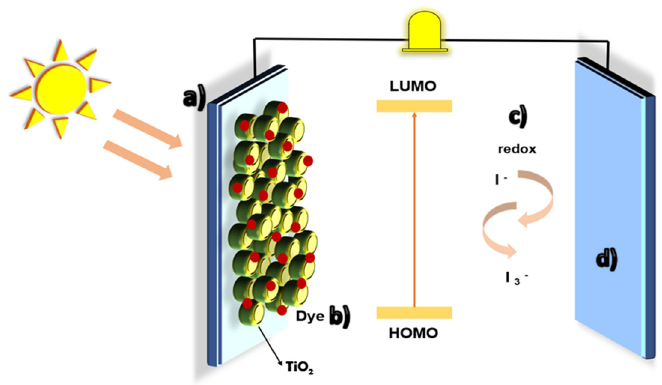
Figure 1. Typical components of a DSSC and functional mechanisms.